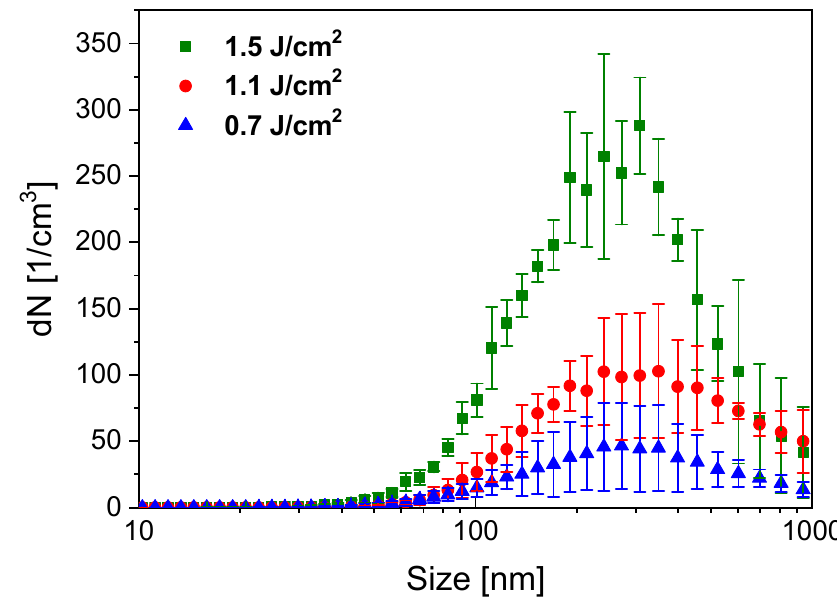
Figure 10. Size distribution of PLA-generated particles for different applied laser fluences.